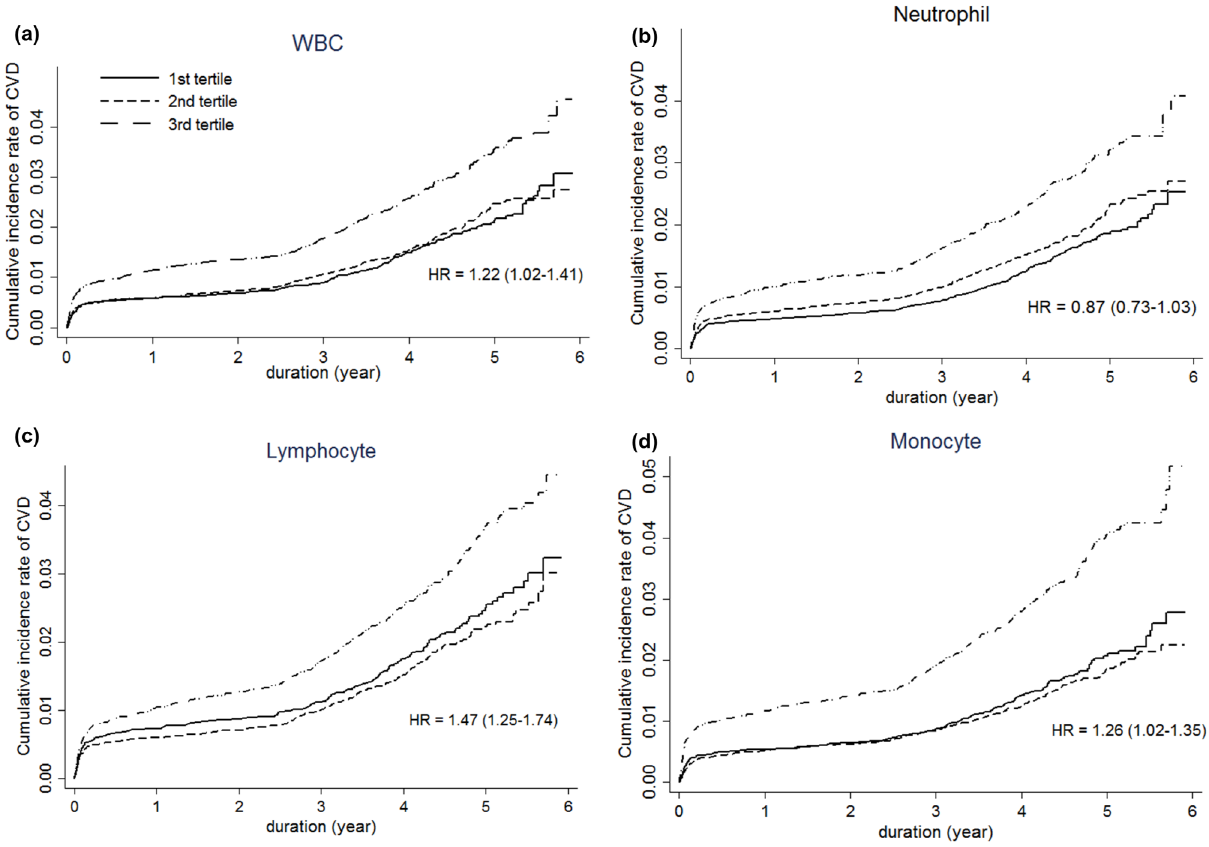
Fig 3. Cumulative Incidence rate of cardiovascular disease according to tertiles of (a) WBC, (b) Neutrophil, (c) Lymphocyte and (d) Monocyte. (Data are shown as hazardratios (HR) of the top to bottom tertile (95% CI); adjustedfor age, gender, BMI, smoking, diabetes, hypertension, dyslipidemia and significantstenosis) (median (years): 5.60 (5.58–5.70)).